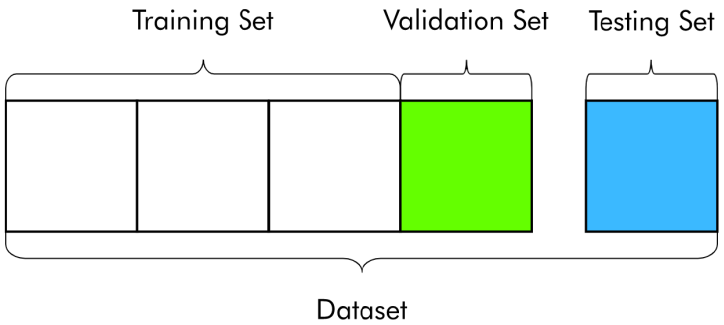
Figure 21. Unsupervised learning — information extraction (Adapted from [29]).